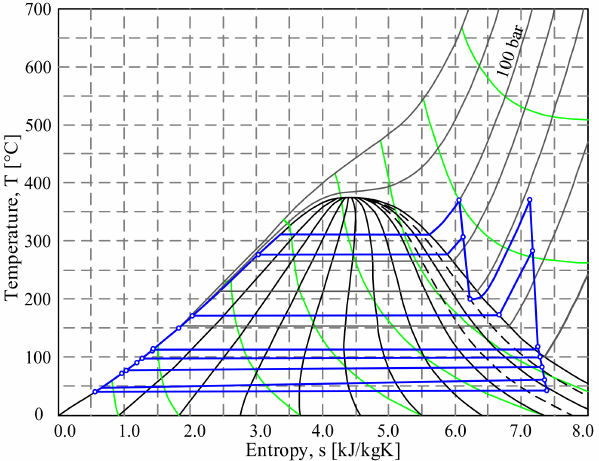
Figure 6. T-s diagram of the steam turbine in the 50 MW CSP